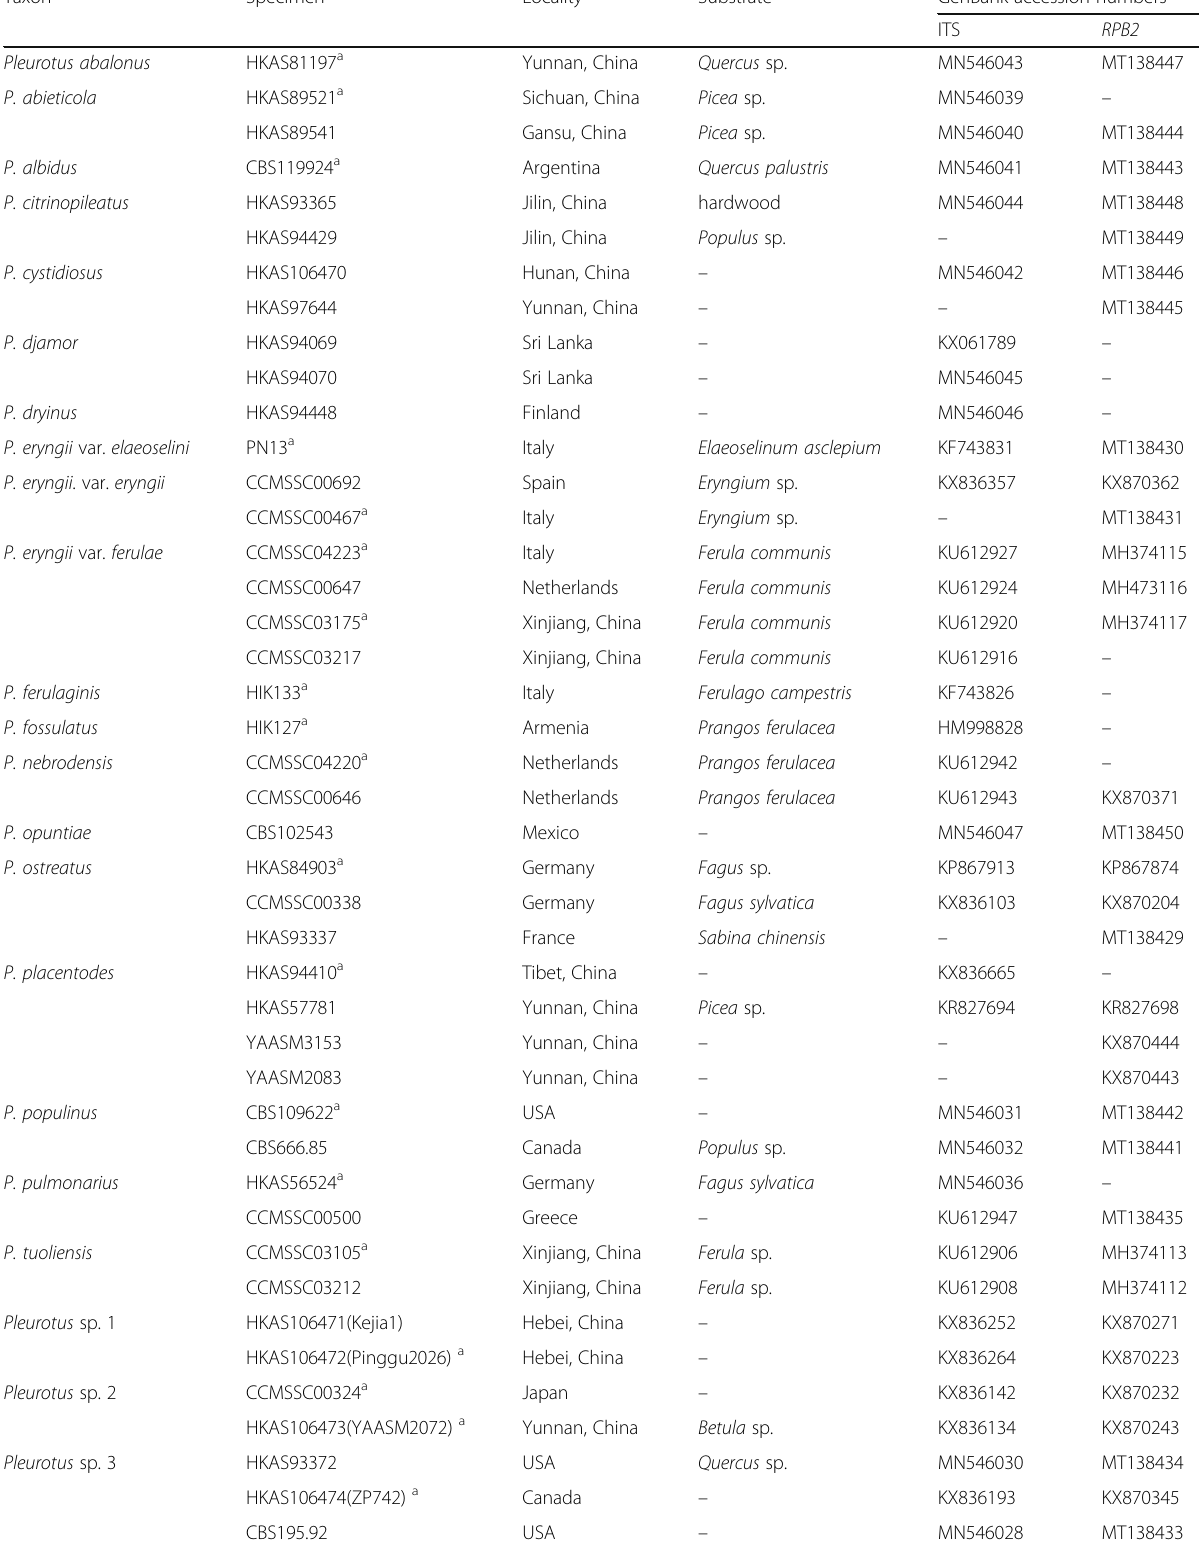
Table 1 List of specimens used to infer the phylogeny of Pleurotus ostreatus species complex